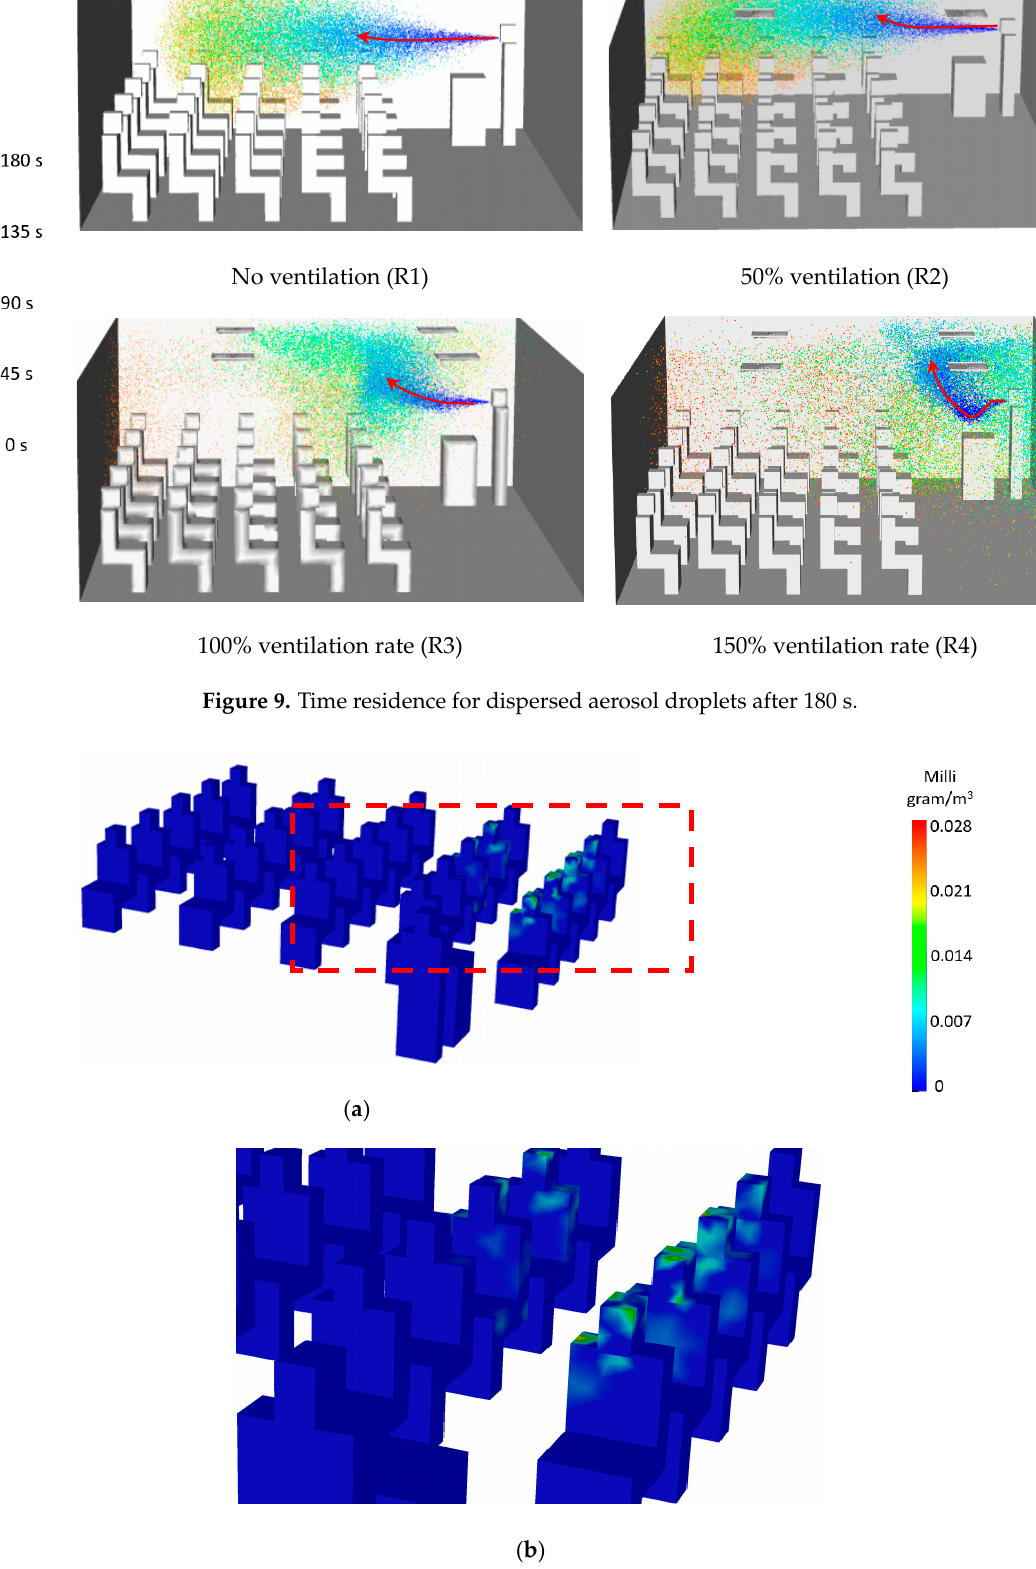
Figure 10. Students exposure areas after 180 s (no ventilation case-R1). ( a ) Full class. ( b ) Zoom-in of the dashed window shown in Figure 10a.